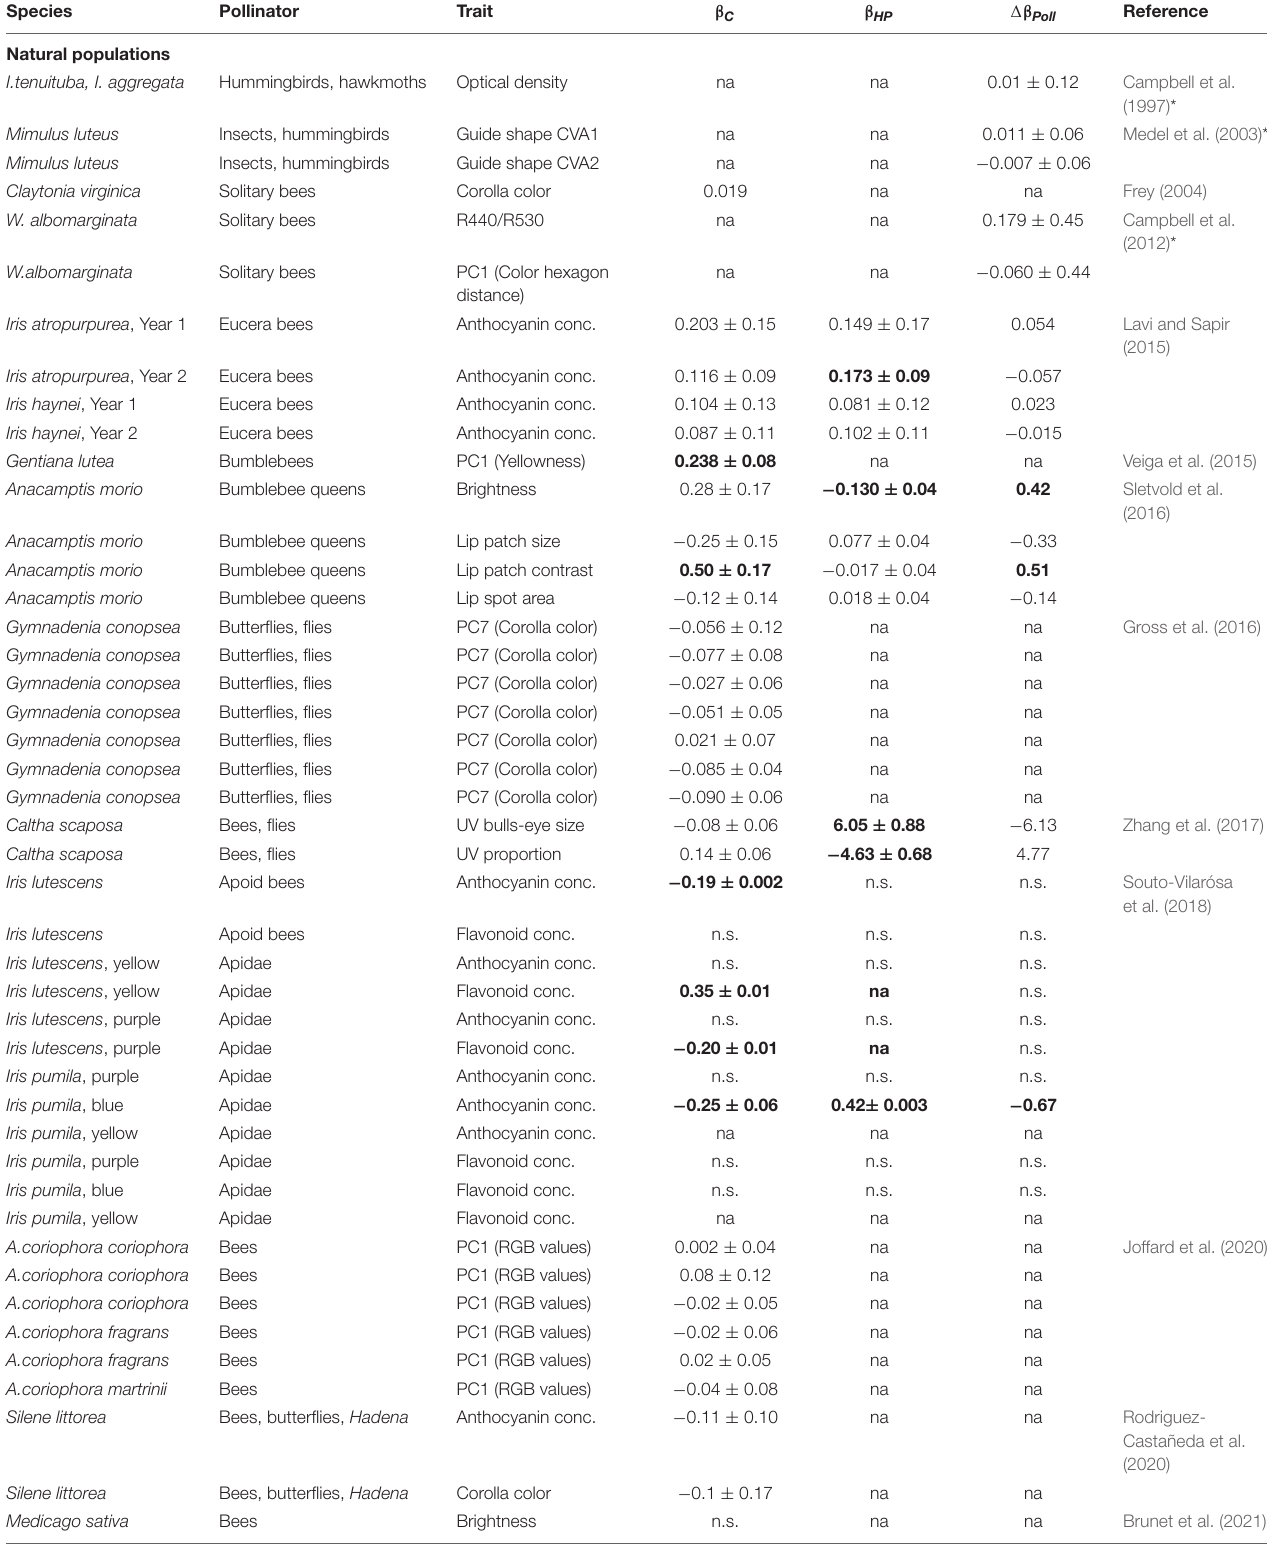
TABLE 2 | Summary of linear phenotypic selection gradients ( ± SE) extracted from the literature for net selection ( β C ) , non-pollinator-mediated selection ( β HP ) and pollinator-mediated selection ((cid:49) β Poll ) on flower color estimated in natural plant populations and experimental